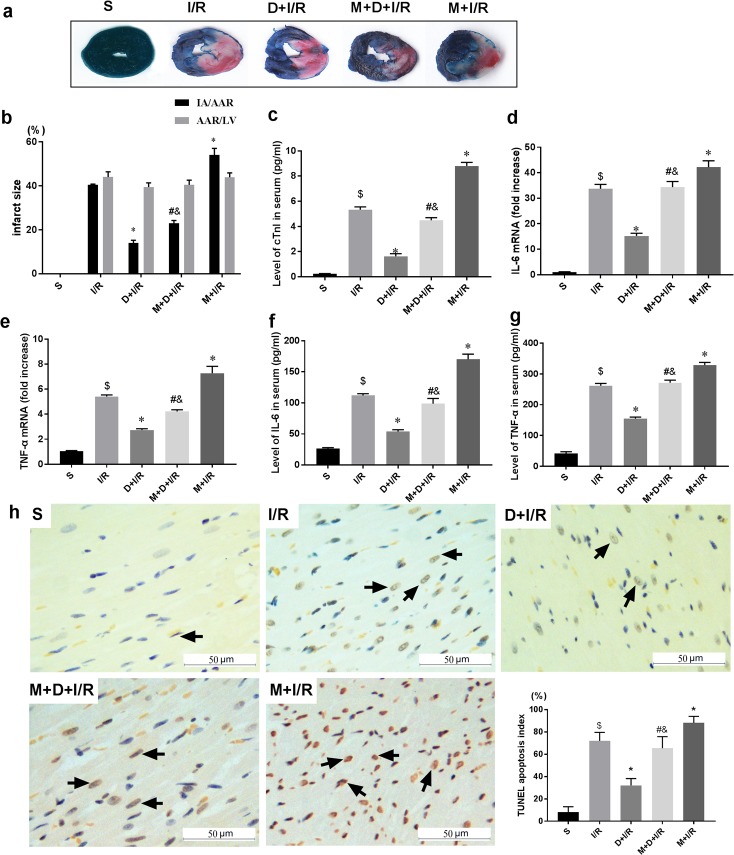
Blockade of the α7nAChR abolishes DEX-induced short-term cardioprotection against I/R.Rats were subjected to intraperitoneal injection of saline or methyllycaconitine (MLA, α7nAChR antagonist) before DEX treatment. (a-b) Infarct sizes determined by Evans blue/TTC staining and representative images of each group are shown. (c) Serum cTnI levels; mRNA levels (d-e) and serum levels (f-g) of inflammatory cytokines including IL-6 and TNF-α were also detected. Myocardial apoptosis in infarct zone was evaluated by TUNEL staining (h) (arrows indicate positive cells, Scale bar = 50μm.); Data shown are mean ± SEM; n = 10 per group; $ p<0.05 vs. S; *p < 0.05 vs. I/R; #p < 0.05 vs. D+I/R; &p < 0.05 vs. M+I/R. All specimen were obtained at the timepoint of myocardial I/R for 2hrs. S: sham operation; I/R: myocardial ischemia-reperfusion; D: dexmedetomidine; M: methyllycaconitine.